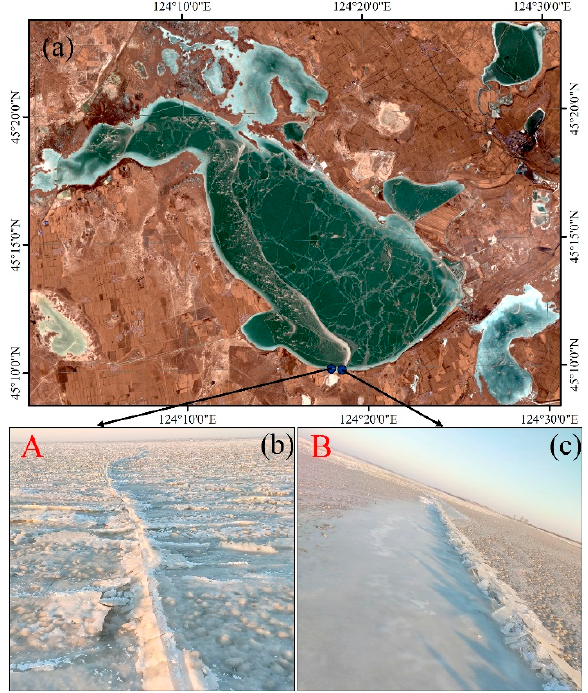
Figure 9. The field validation of lake ice fracture : ( a ) Landsat OLI image on February 25, 2019; ( b , c ): field photos of the lake ice ridge on 20 December 2020 .